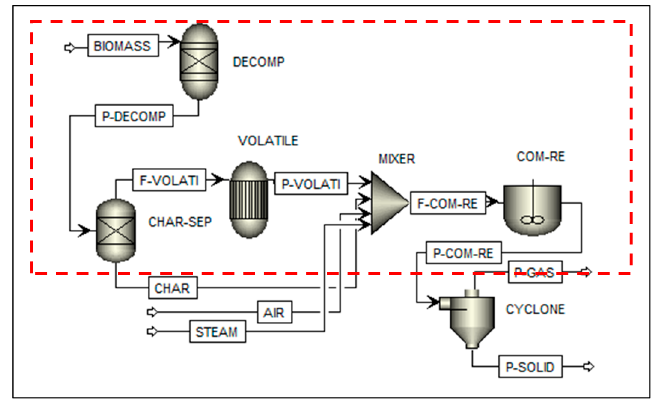
Figure 9. The system of energy balance in the steam gasification process.